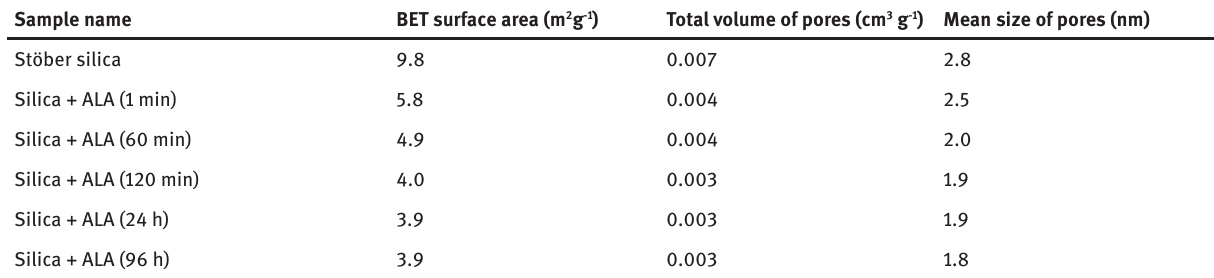
Table 2: Parameters of porous structure of both silica and silica after enzyme immobilization. Sample name